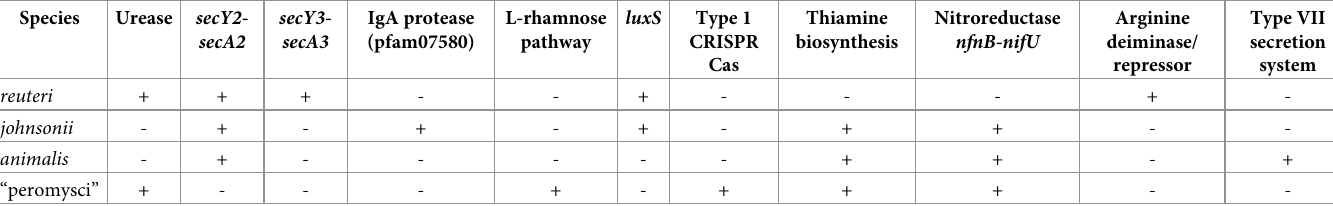
Table 2. Selected genes and pathways in four species of Lactobacillus of the gastrointestinal microbiota of Peromyscus leucopus